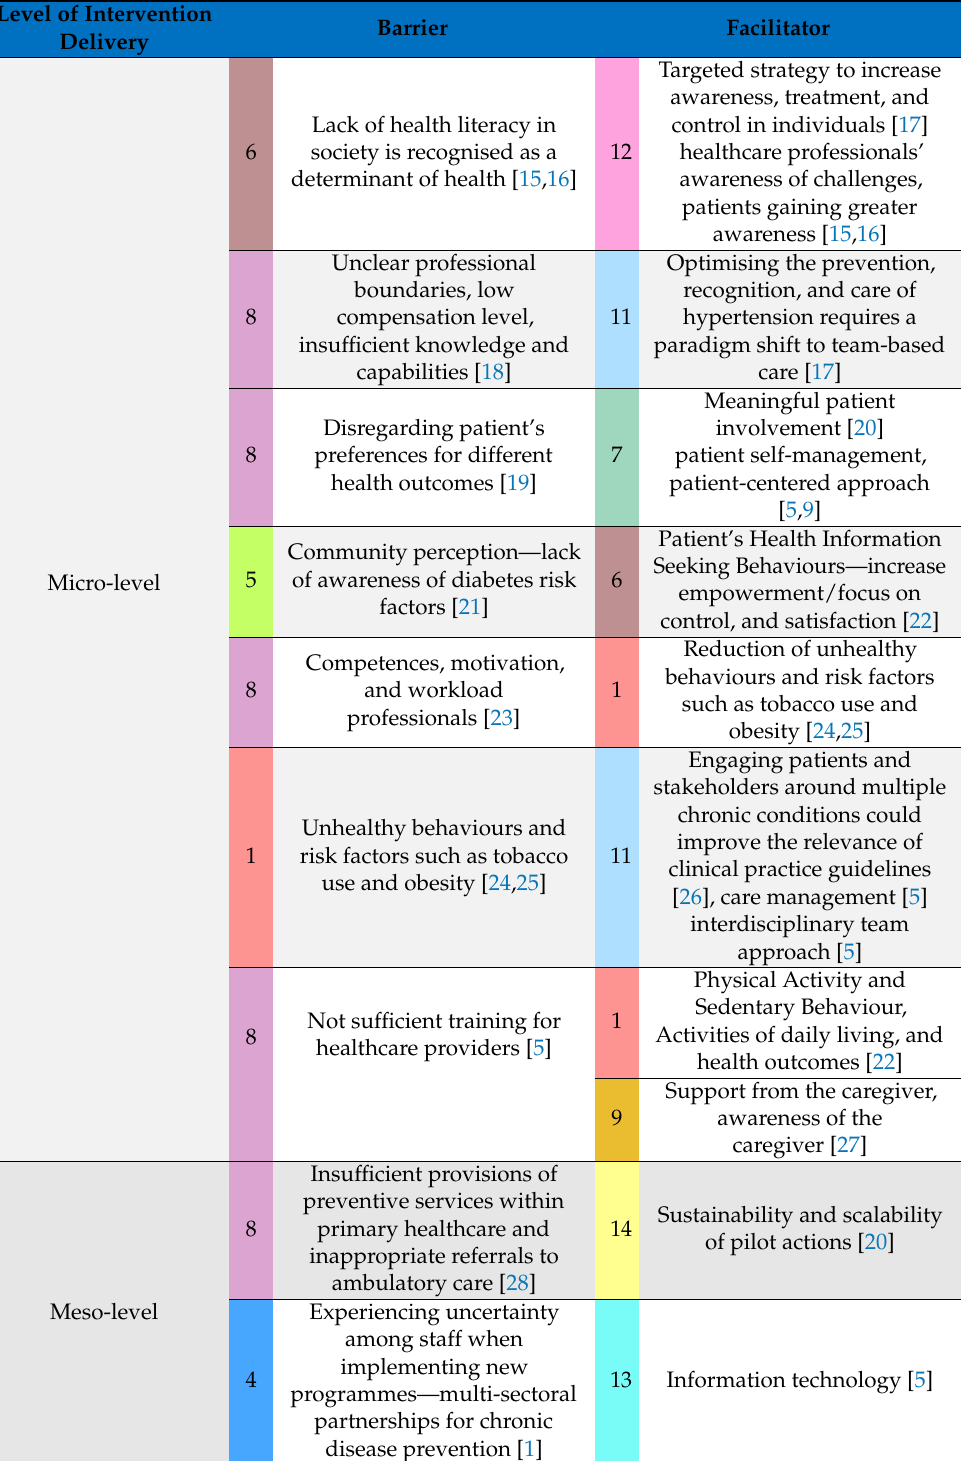
Table 2. Barriers to and facilitators of intervention implementation concerning the level of interven- tion